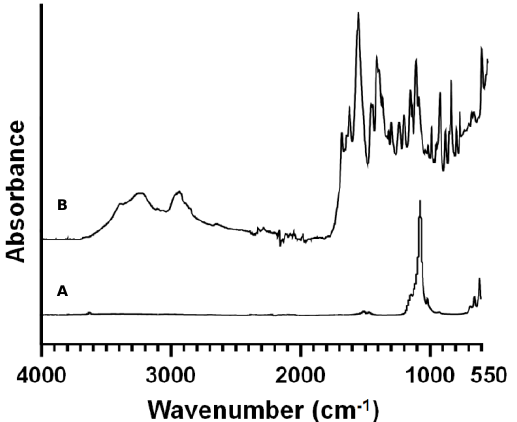
Figure 2. ATR-FTIR spectra of the 3D porous glass-ceramic scaffold before ( A ) and after Layer − by − layer surface modification ( B ). Resolution = 4 cm −1 .